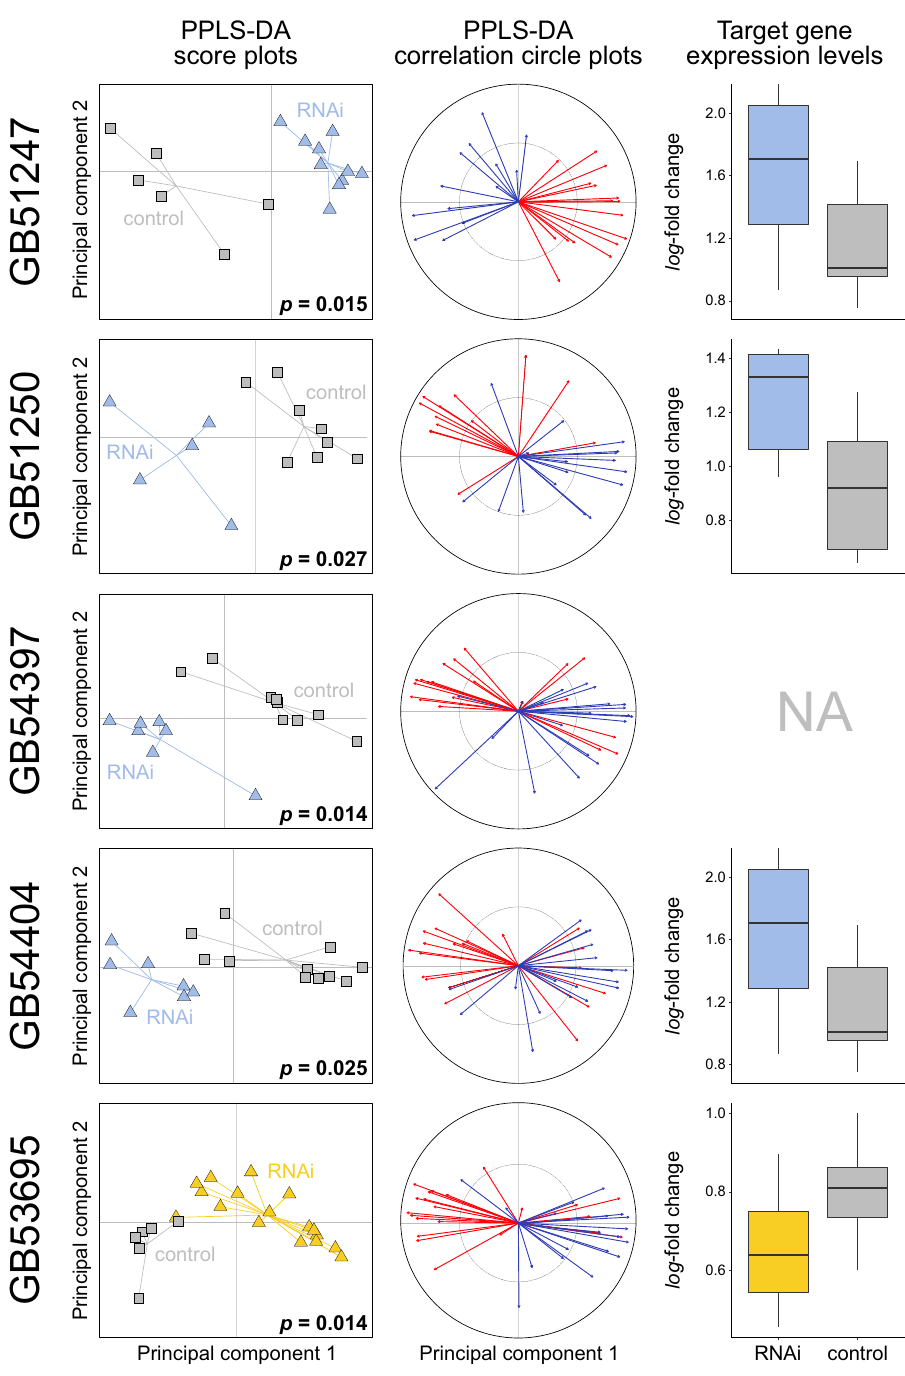
Fig. 5 Effects of RNAi-mediated knockdown of four fatty acid elongases and of one fatty acid amide hydrolase (FAAH) in worker honey bees ( Apis mellifera ) 2 – 5 days after dsRNA treatment. The fi rst two columns show score plots and correlation circle plots from a powered partial least squares discriminant analysis (PPLS-DA) of the cuticular hydrocarbon (CHC) pro fi le data of target gene-treated (in blue for fatty acid elongases RNAi: GB51247 , GB51250 , GB54397 , GB54404 , in yellow for FAAH RNAi: GB53695 ) and of control bees (in grey, injected with dsRNA targeting GFP). P -values indicate the statistical probability of group differences representing random variation after Benjamini-Hochberg correction for multiple (N = 10) testing. The correlation circle plots indicate how many CHCs of a given chain length class (i.e., ≤ 27 [red] or > 27 [blue] carbon atoms) correlate with the fi rst two principal components. Box plots in the third column show gene expression levels ( log 2 -fold change) of the target genes in target gene-treated (in blue for elongase RNAi, in yellow for FAAH RNAi) and in control bees (in grey). None of the expression levels differed statistically signi fi cantly between target gene-treated and control bees after applying Benjamini-Hochberg correction for multiple testing (N = 9; Welch ’ s t-test and Wilcoxon signed-rank test). Additional information is shown in Supplementary Fig.